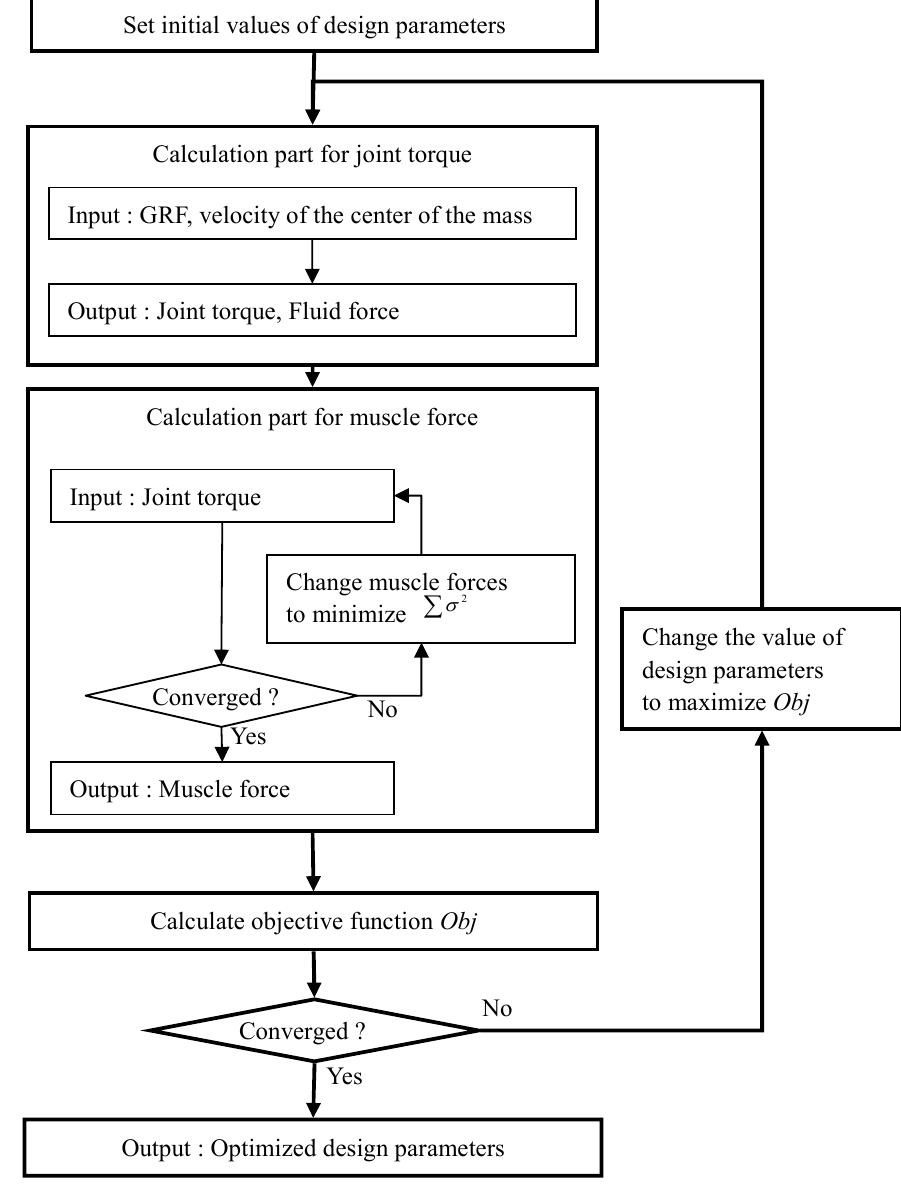
Fig. 1 Calculation flow of the simulator for optimization of walking